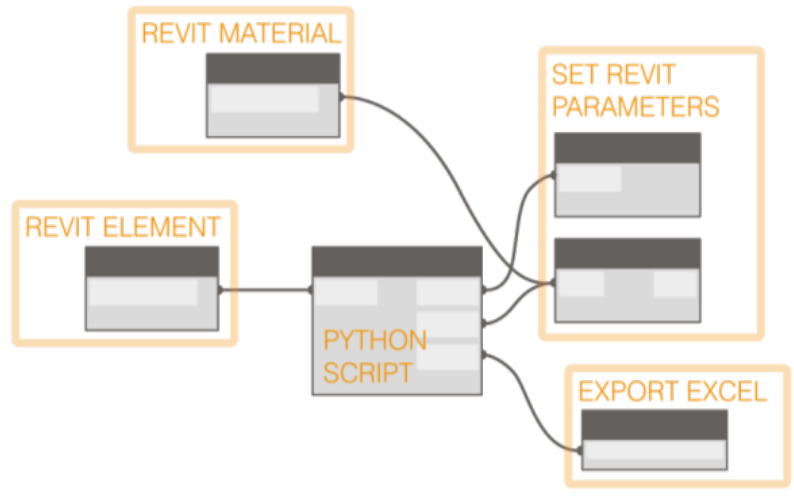
Figure 5. Dynamo framework for accessing the model data.